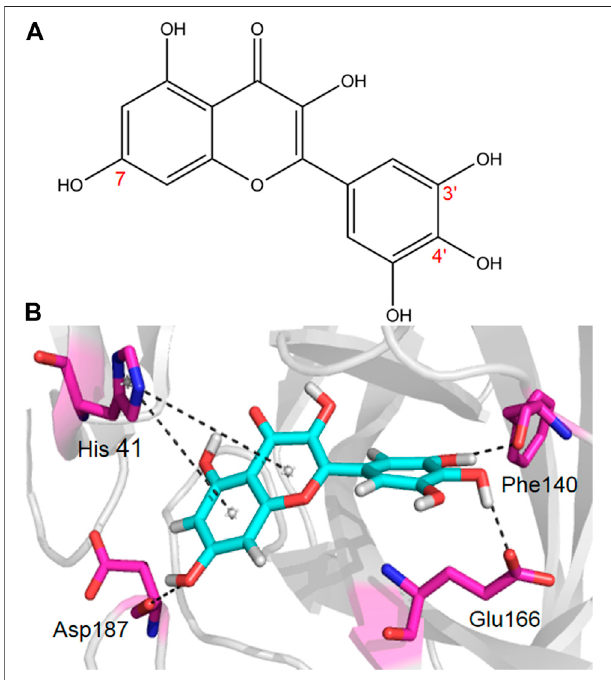
FIGURE 2 | The binding mode of Myricetin in SARS-CoV-2 Mpro. Hydrogenbondsand π - π interactionsbetweenMyricetinandSARS-CoV-2M pro are represented by dashed